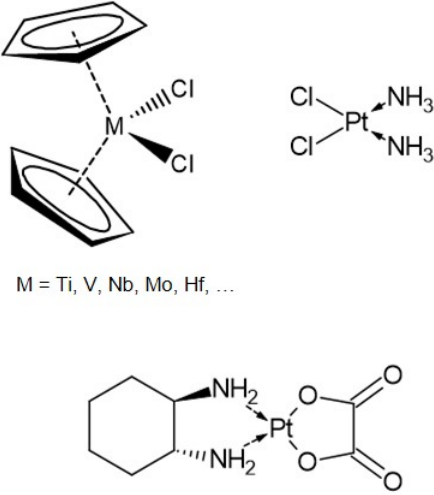
Figure 1. Structure of bent metallocene dichlorides (M = Ti, V, Nb, Mo, Hf, ...), cisplatin, and its derivative oxaliplatin.